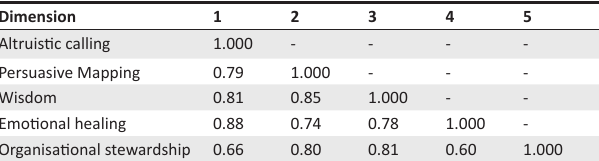
TABLE 5: Phi matrix of the latent servant leadership questionnaire dimension inter-correlations. Dimension